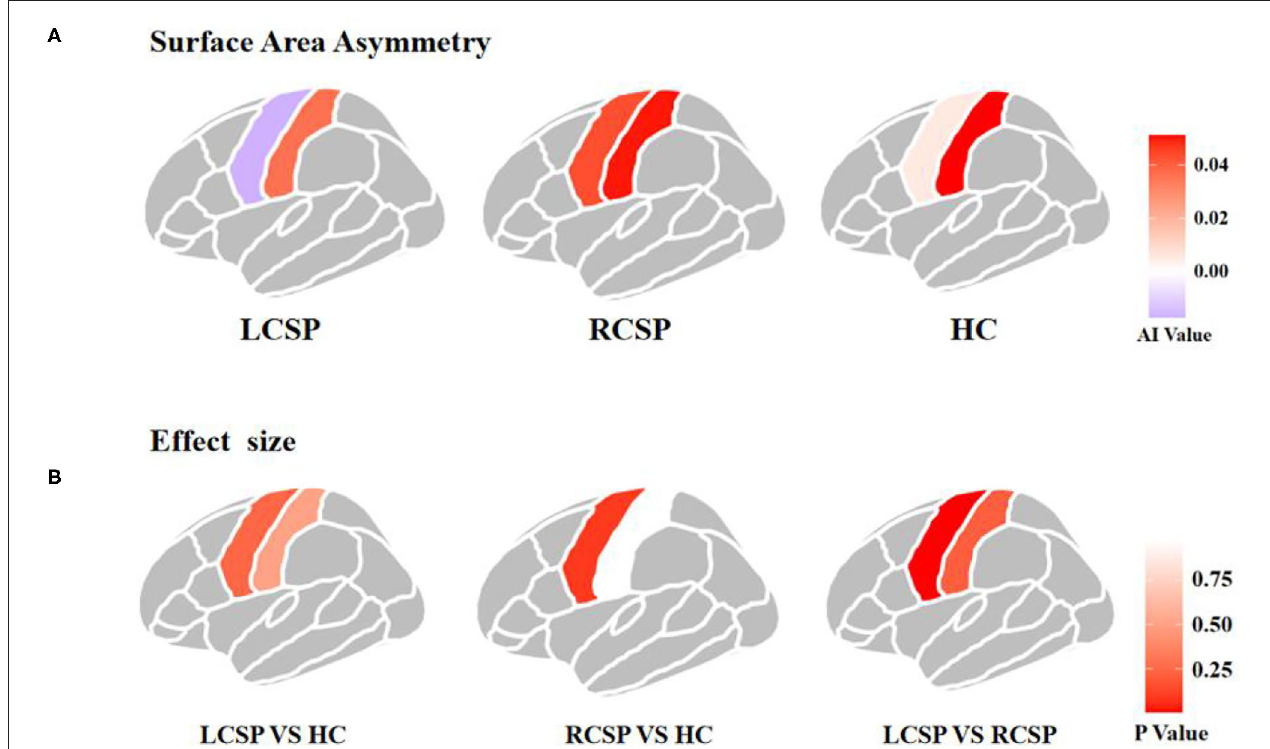
FIGURE 1 | Asymmetry of surface area and effect sizes in the precentral and postcentral gyrus in three groups. (A) Asymmetry of surface area in the precentral and postcentral gyrus. Colors indicate the directions of average interhemispheric differences, with red indicating leftward asymmetry, and purple indicating rightward asymmetry. (B) Region-wise effect sizes of hemispheric asymmetry. Effect sizes are Cohen’s d values.